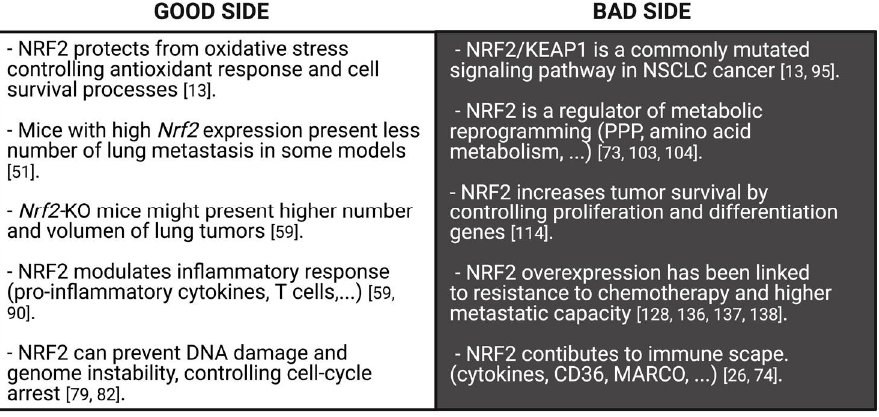
Figure 5. Good and bad sides of NRF2 against lung cancer. NRF2 exhibits a dual role in lung cancer. On one hand, NRF2 protects from oxidative stress generated in cancerous development by controlling genes implicated in antioxidant and cell survival processes, which maintain an appropriate level of intracellular antioxidants. Indeed, NRF2 prevents DNA damage, genome instability and cell cycle-arrest. Moreover, NRF2 modulates the inflammatory response through an increase of T cells. As a consequence, Nrf2 -knockout mice show high number and volume of lung tumors and Nrf2 -high mice present a small number of lung metastasis. On the other hand, the NRF2/KEAP1 pathway is a commonly mutated signaling pathway in human lung cancer and some pro-oncogenic functions of NRF2 provide an advantageous condition for the progression of cancer cells. NRF2 is an important regulator of metabolic reprogramming and cancer proliferation. Both processes are important for cancer progression. Concurrently, NRF2 overexpression has been correlated with lower sensitivity to chemotherapeutic drugs and with high metastatic capacity. Finally, NRF2 contributes to immune escape by inducing a decrease of pro-inflammatory cytokines.